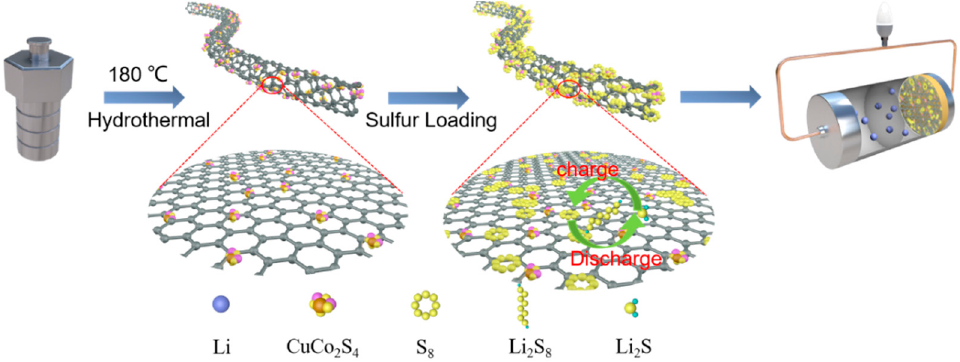
Figure 1. Schematic diagram showing the synthesis and structure of S/CuCo 2 S 4 /CNT.